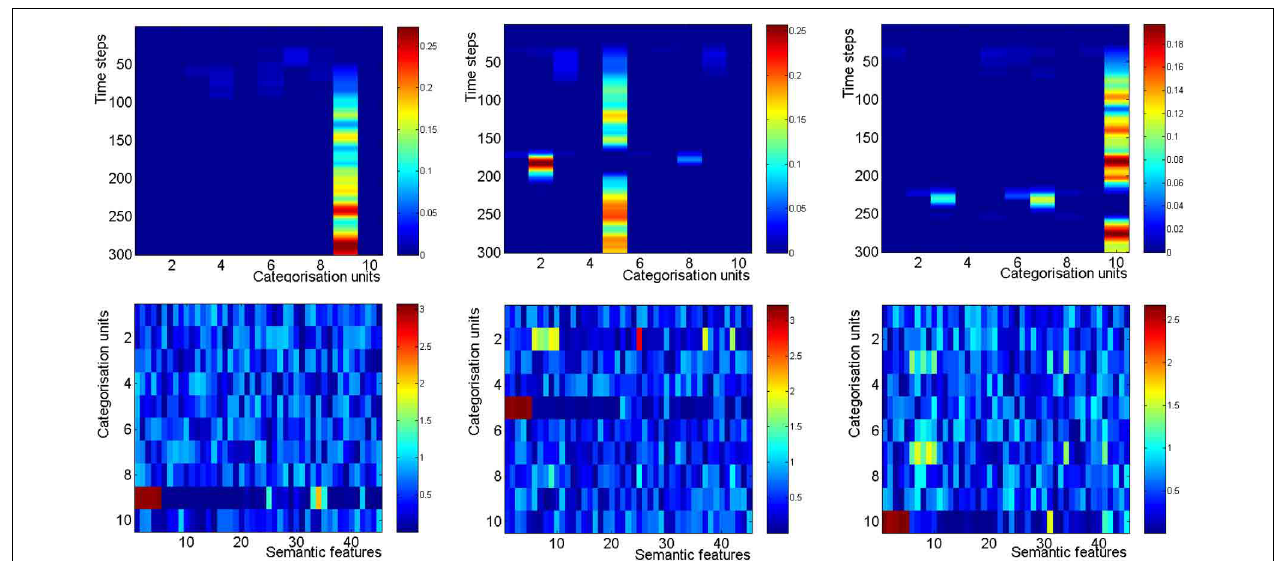
FIGURE 7 | The categorization layer in a Von Restorff simulation. In both panels, the isolate appears in serial position 1 (left) 7 (middle) and 9 (right). An isolate at position 7 gets activated during time steps 150–175, and an isolate in serial position 9 gets activated during time steps 200–225. Warmer colors represent higher activations. Top : The activation in the categorization layer, in a simulation which includes